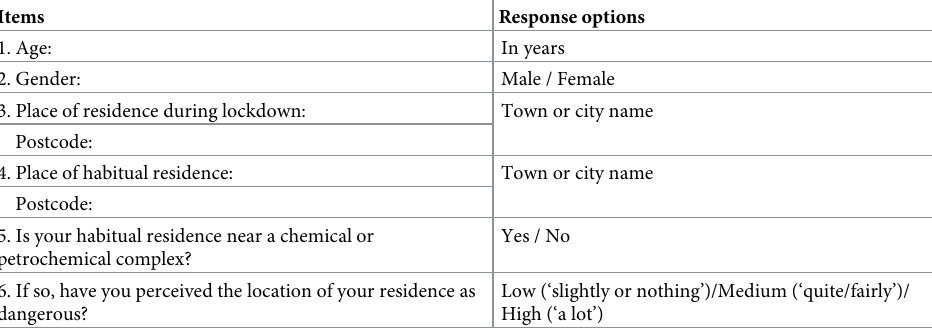
Table 1. Items included in the first section of the Petrocovid Survey